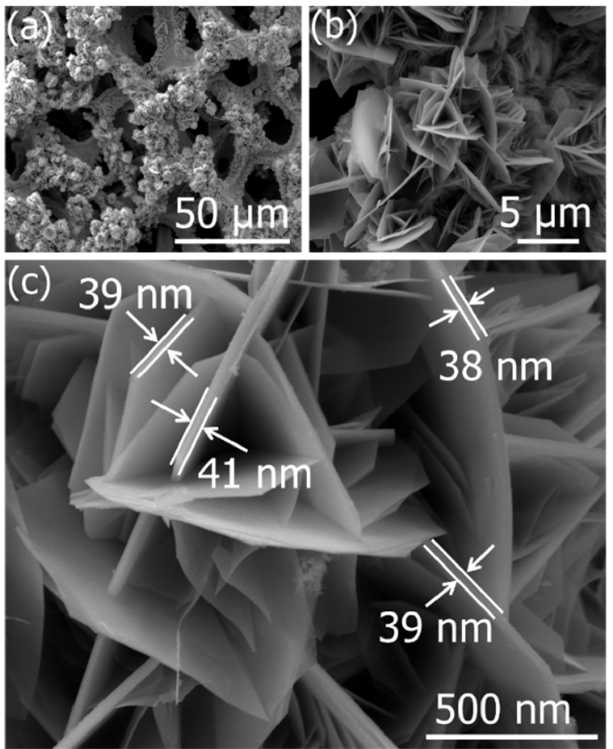
Figure 2. The SEM images of ZnCoO@NF at different magnifications: ( a ) low, ( b ) medium, and ( c ) high.